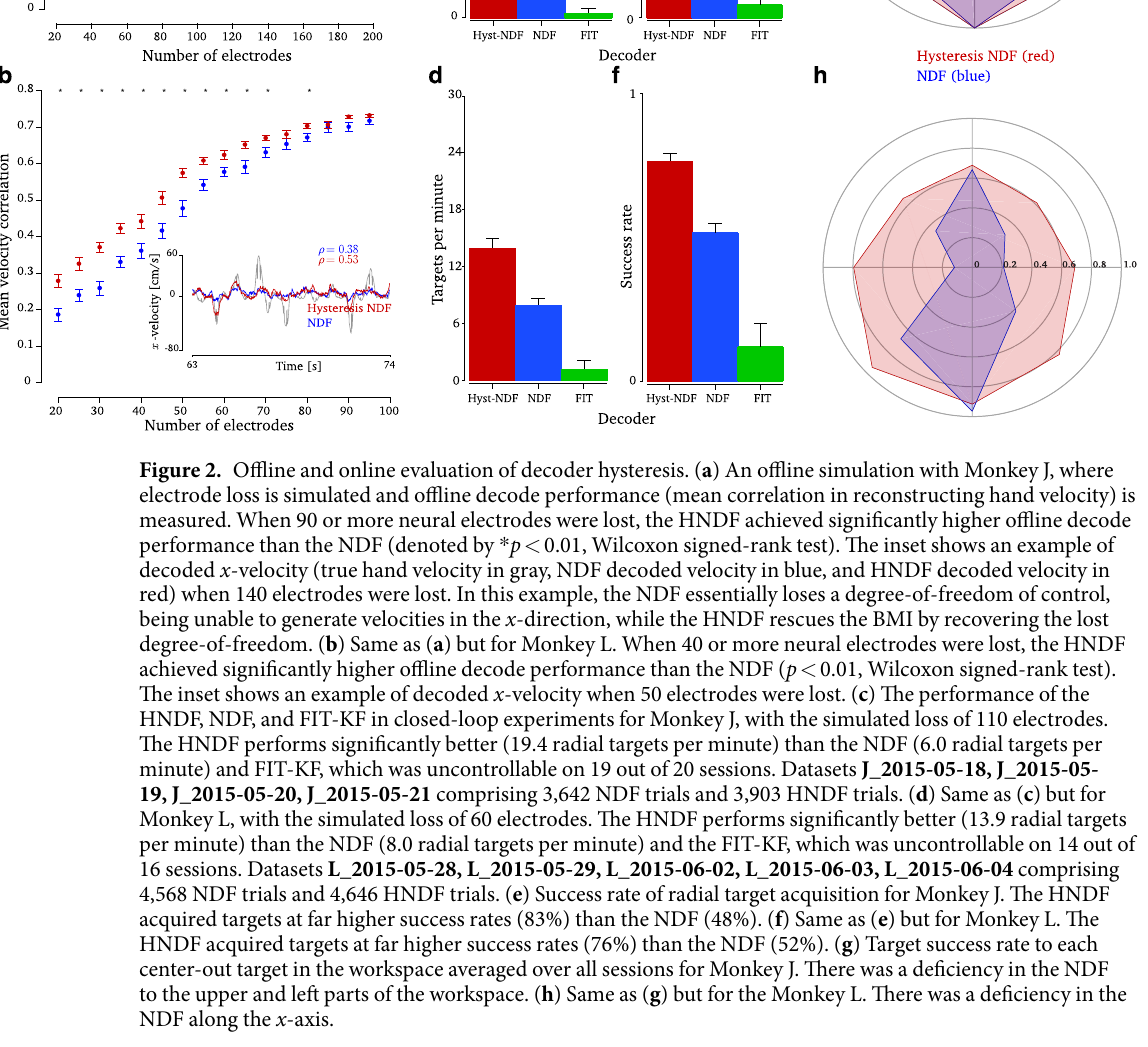
(red traces in the Fig. 2a,b inset). These control anisotropies in the NDF decoder were similarly reflected in closed-loop BMI experiments. Monkey J had difficulty reaching the upper left part of the workspace using the NDF decoder, although he was capable of acquiring all targets with the HNDF decoder (Fig. 2g). Monkey L had difficulty reaching in the horizontal direction with the NDF decoder, but was capable of reaching all targets with the HNDF decoder (Fig. 2h). One way to view these results is in a dynamical systems perspective. In the NDF and HNDF decoders, we are using a dynamical system to infer a neural population state , which is a low-dimensional projection of the neural activity that summarizes the correlated activity across the population (see Methods). Critically, each decoder’s neural dynamical model influences the trajectory of the neural population state 32 . Hence, these observations imply that the remembered dynamical model (HNDF decoder) drives the neural state to traverse regions of state-space that are more informative of BMI kinematics. In contrast, the re-learned dynam- ical model (NDF decoder), while locally optimal in explaining the neural activity in a maximum-likelihood sense, drives the neural population state in subspaces that are less informative of BMI kinematics.